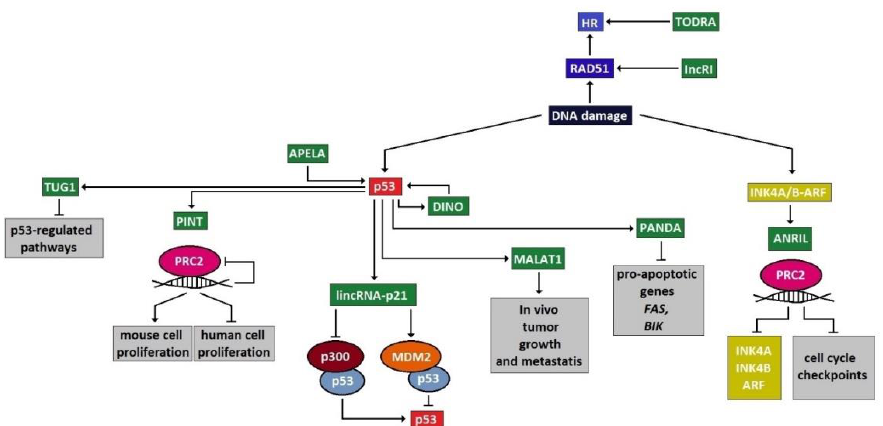
Figure 2. Schematic illustrating the different levels of DDRR regulation exerted by lncRNAs (pre- sented in green color). LncRNAs interact with various components of the DDRR network, by either promoting or inhibiting their functions.